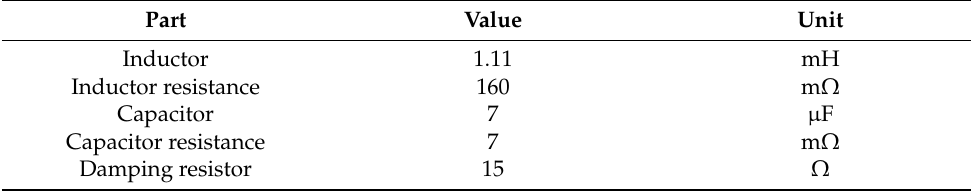
Table 2. Parameters of the input filter in the simulation.